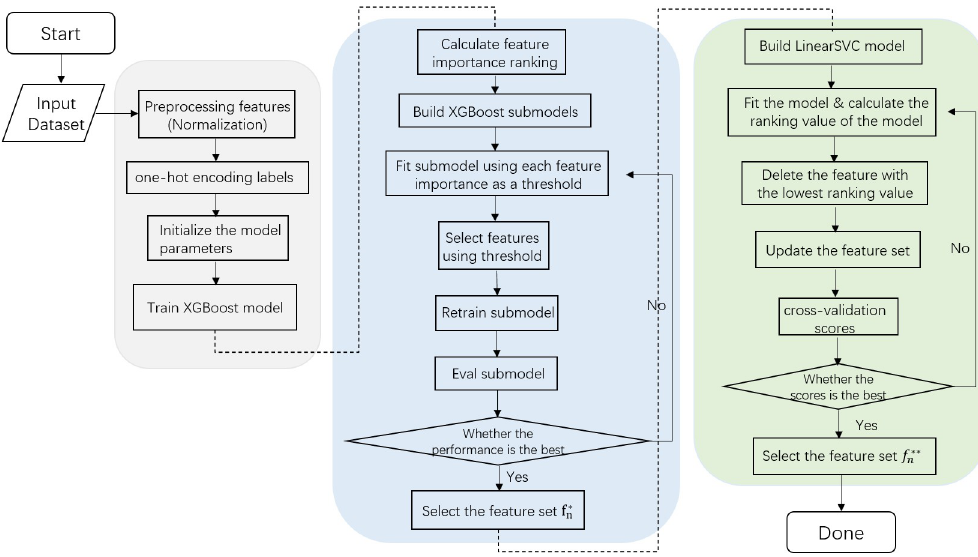
Fig 2. Flowchart of the hybrid feature selection